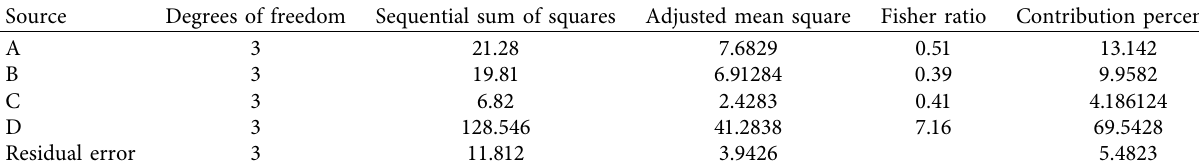
Table 8: Statistical ANOVA for the correlation between signal and noise.